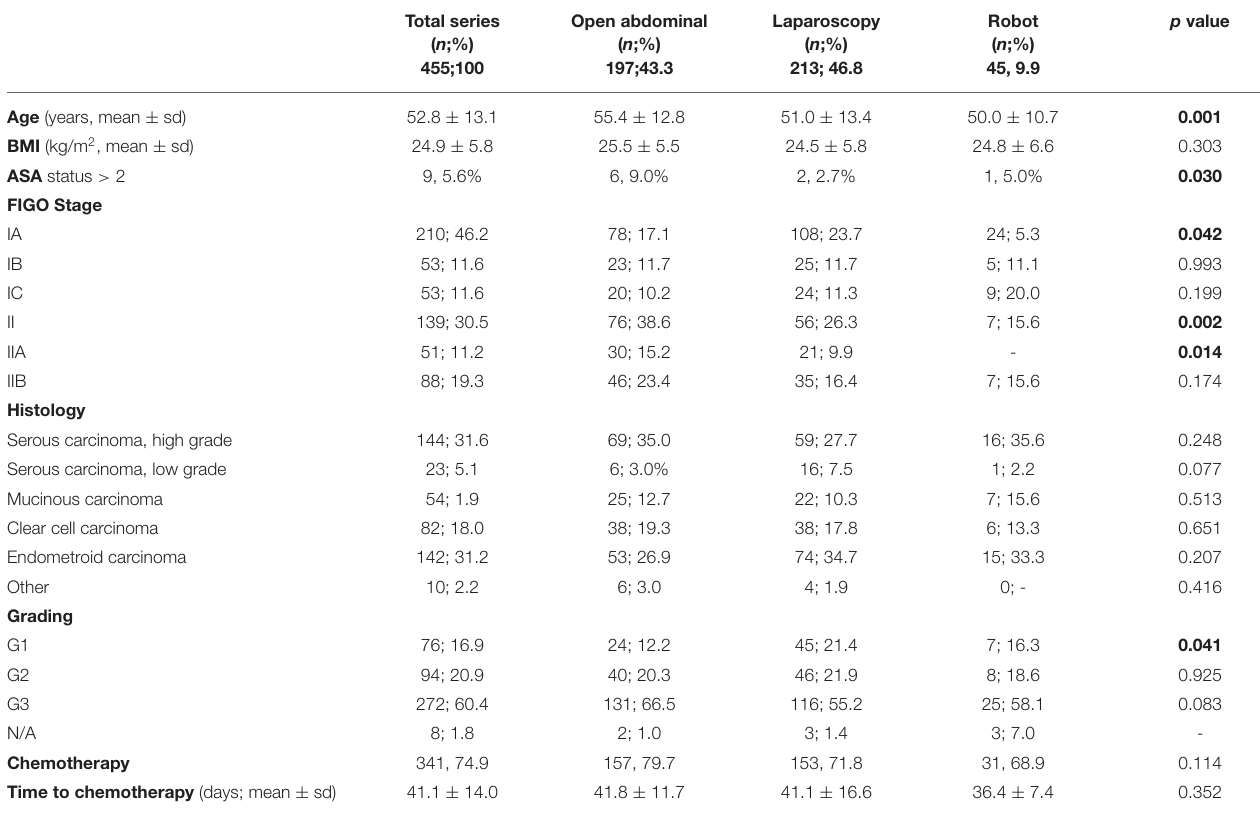
TABLE 1 | Patients’